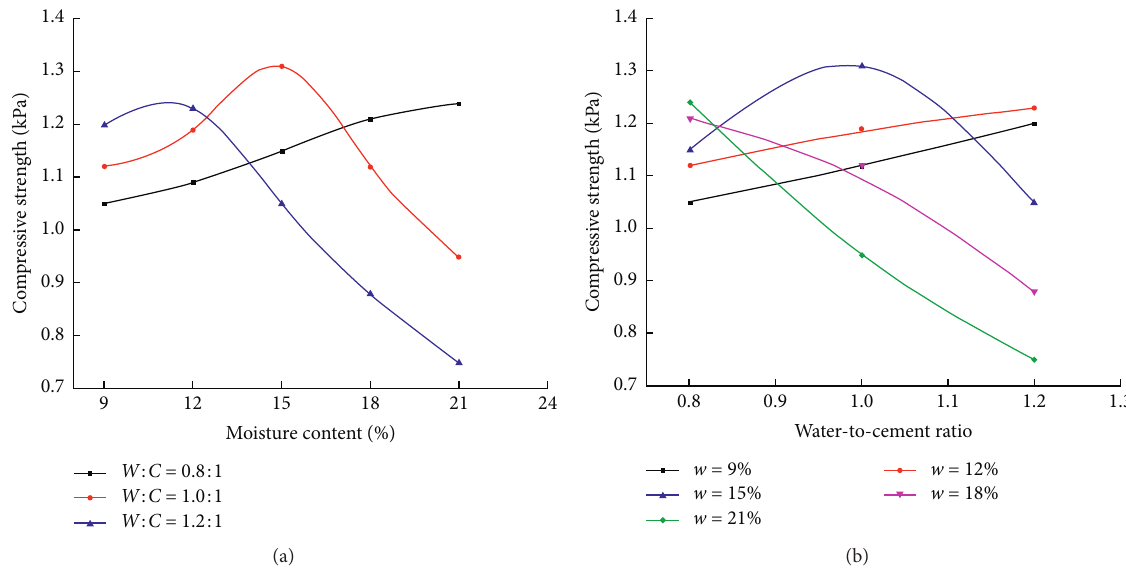
Figure 8: Reinforced loess compressive strength vs. moisture content and water-to-cement ratio. (a) q